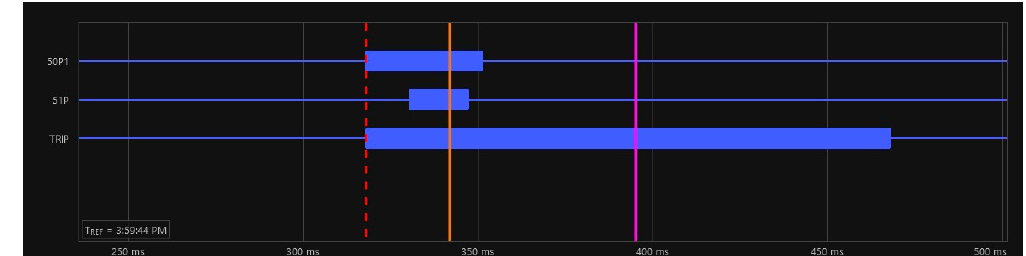
Figure 32. Trip logic and trip signal recorded by R2 under instantaneous scheme.